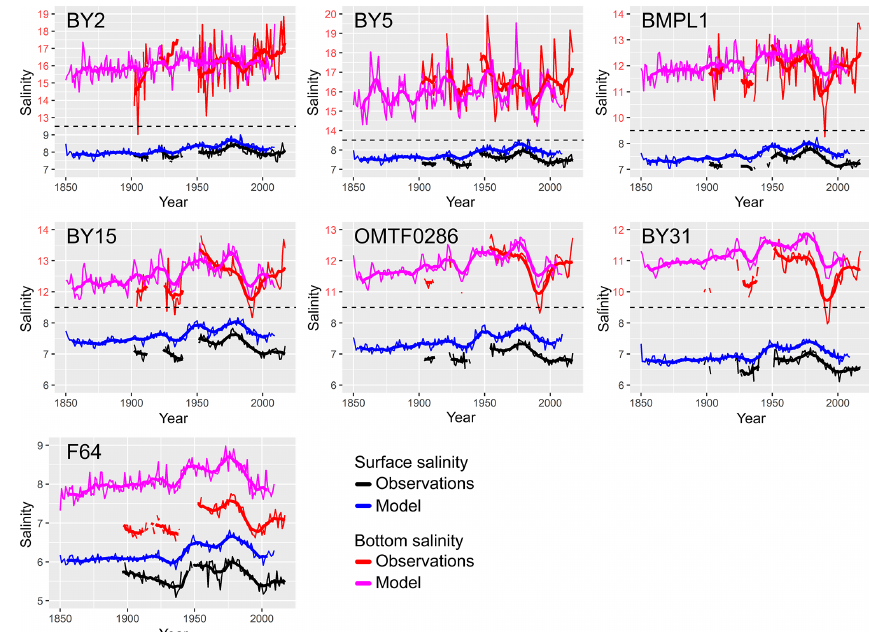
Figure 4. Surface and bottom salinity at selected oceanographic stations from observations and model. Thin lines: annual averages. Thick lines: 11-year running mean. Data are corrected for seasonal observation bias. Running mean is shown where at least 6 years of data were available. Dashed lines and red axis annotations indicate a broken salinity axis for better visibility. Table 1. Basic statistics for fit between model and observations with respect to surface and bottom salinities. Station Decadal mean salinity Annual mean salinity Surface Bottom Surface Bottom Expl. var. RMSE Expl. var. RMSE Expl. var. RMSE Expl. var. RMSE (%) (g kg − 1 ) (%) (g kg − 1 ) (%) (g kg − 1 )